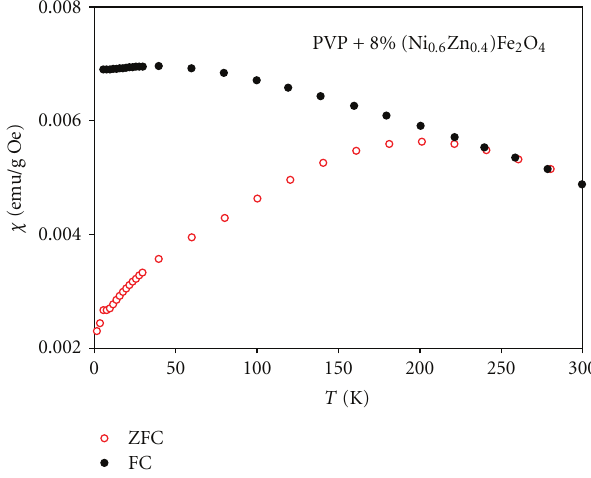
Figure 8: Temperature dependence of magnetic susceptibility at 100 Oe for zero-field-cooled and field-cooled PVP + 8% MNP, showing a blocking temperature near 250